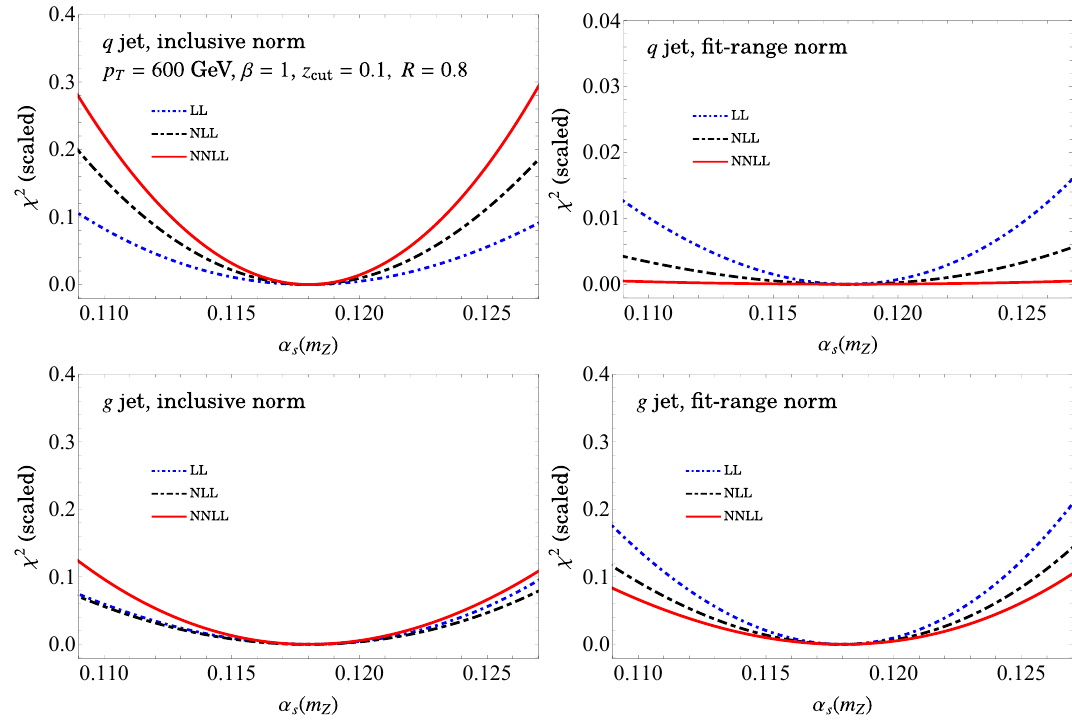
Figure 12 . Values of χ 2 obtained by varying α s ( m Z ) . Left panels show quark jets and right panels show gluon jets. Upper panels normalize to the inclusive cross-section, while lower panels normalize to a fixed jet-mass fit range in the SDOE region. When normalized to the fit range, the quark jets loose sensitivity to α as seen from the different y-axis scales in the left panels. The s bottom panels also show that both quark and gluon jets loose sensitivity to α when cross sections s are normalized in the fit range, whereas this is not the case when the inclusive cross section is used for the